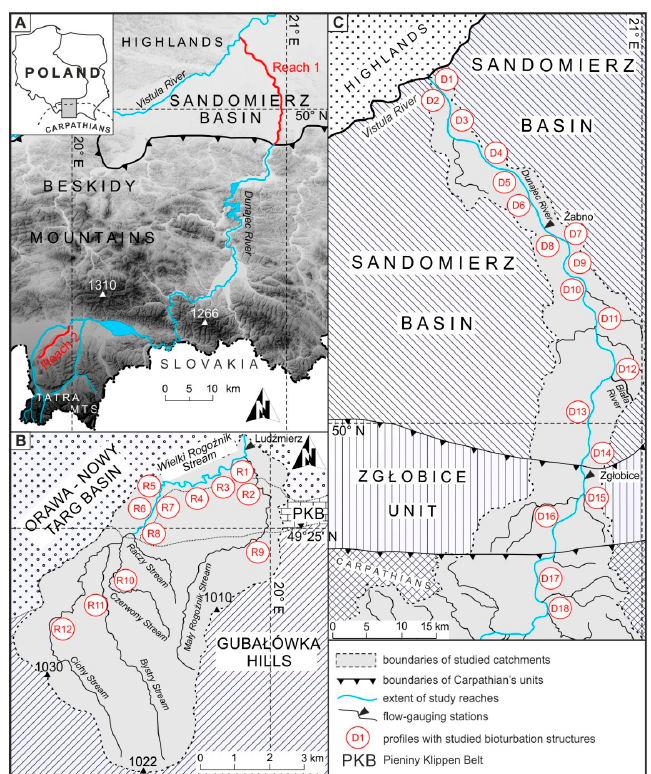
Figure 1. ( A ) Location of the studied reaches in relation to physiogeographic regions of southern Poland. Drainage network of Wielki Rogo´znik Stream, ( B ) and of the lower reach of the Dunajec River ( C ) with detailed setting of studied profiles.